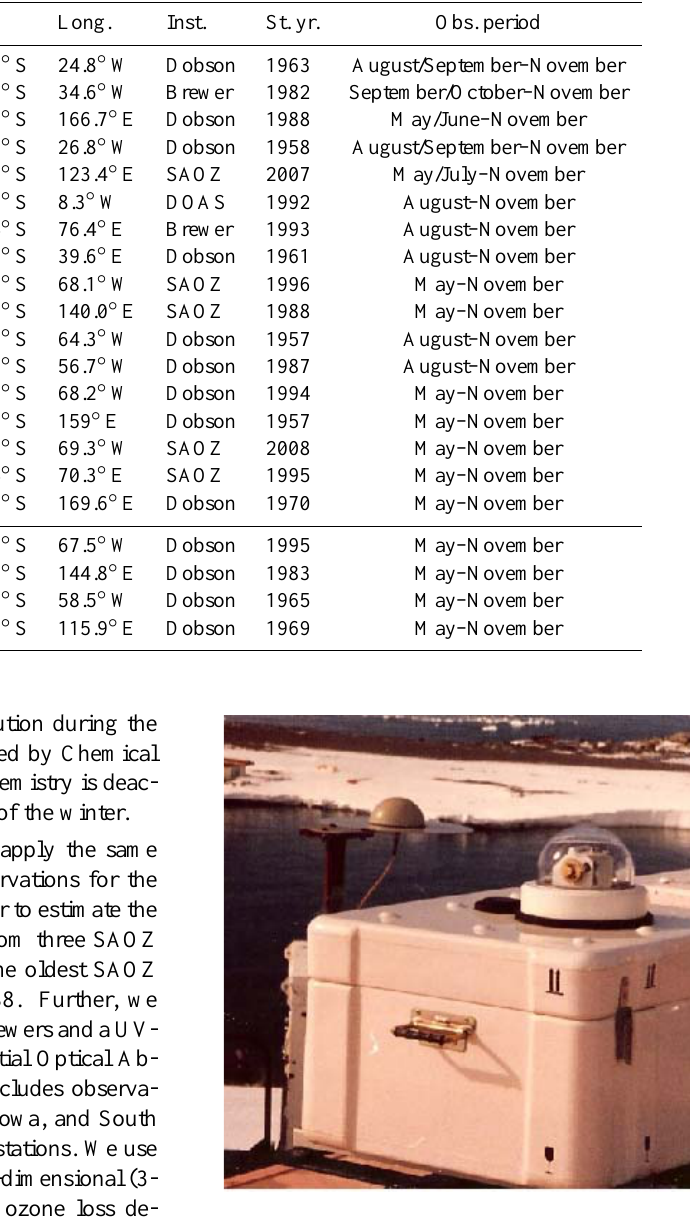
Fig. 1. The SAOZ instrument at Dumont d’Urville in the